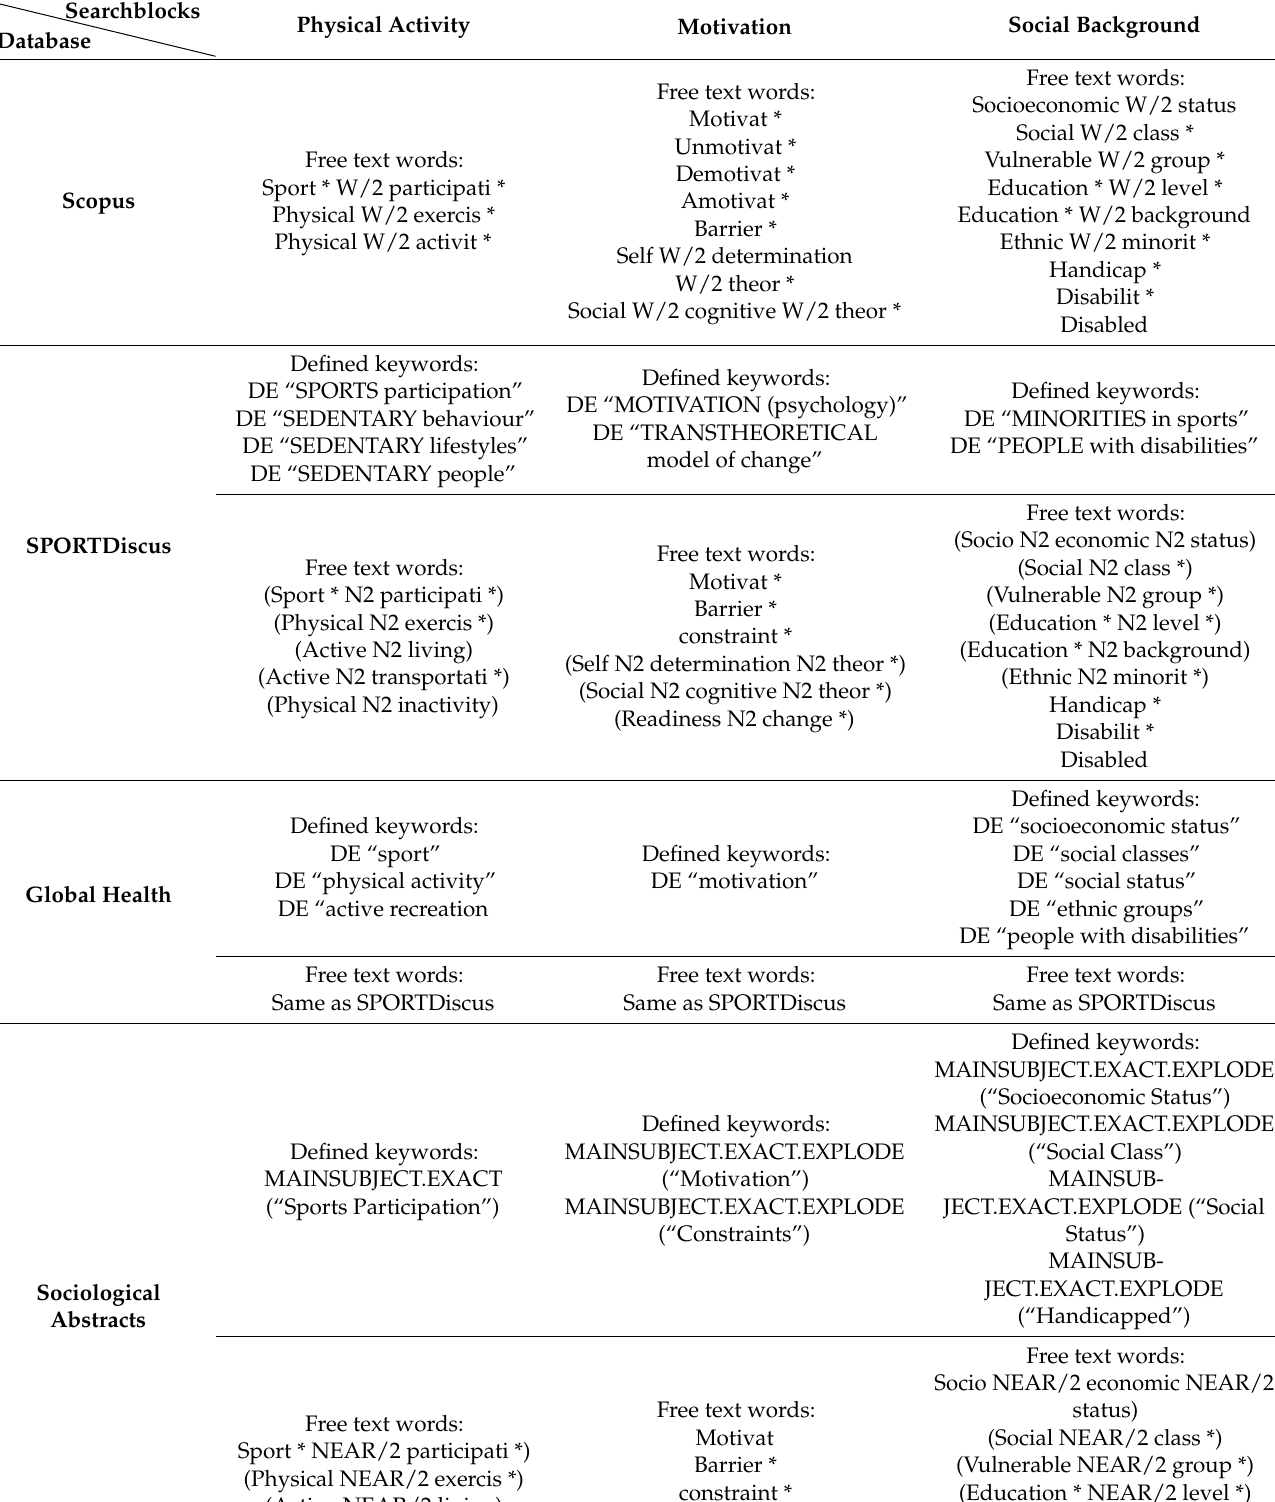
Table 1. Search terms in the four selected